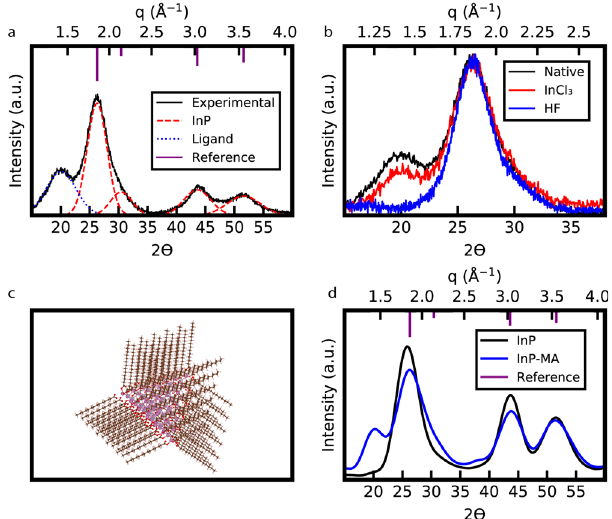
Fig. 1 Experimental and simulated powder X-ray diffraction spectra of indium phosphide quantum dots with organic capping ligands. a Powder X-ray diffraction spectra with peak deconvolution of indium phosphide quantum dots capped with myristate. b Powder X-ray diffraction spectra of indium phosphide quantum dots with the myristate ligands partially removed by indium chloride and completely removed by hydro fl uoric acid. c Atomic model of a tetrahedral indium phosphide quantum dot capped with myristates. d Simulated powder X-ray diffraction patterns of indium phosphide quantum dots with and without capping myristates (MA). Cu K- α ð λ ¼ 1 : 5418 Å Þ is the X-ray source for all experimental and simulated powder X-ray diffraction